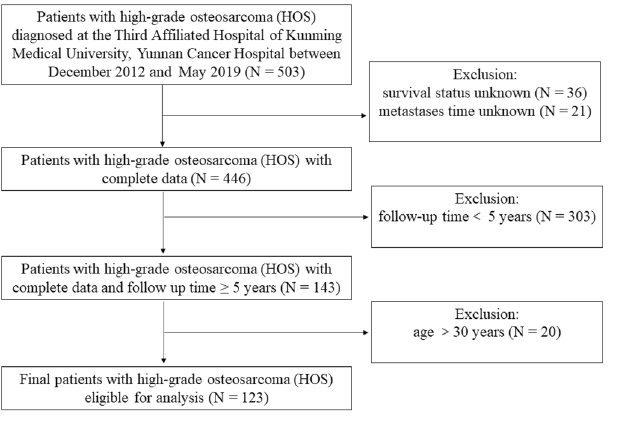
Figure 5. Flow diagram of